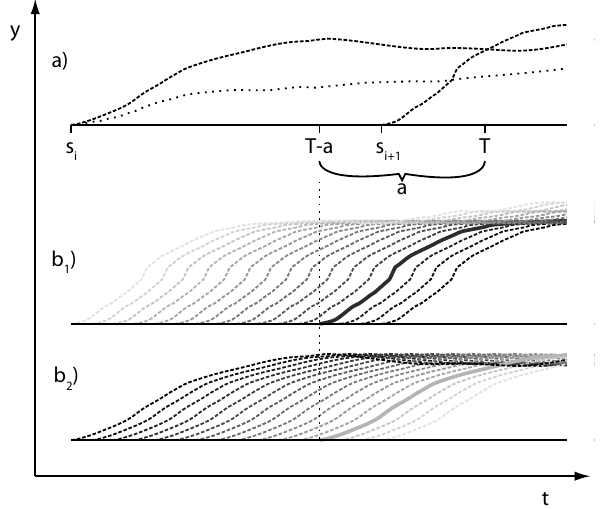
Fig. 2. Principle of GAPPARD applying changing drivers. a) dashed lines: developments of two subsequent trajectories starting from s i and s (i+1) ; dotted line: result after applying the GAPPARD method using both trajectories. b 1 ), b 2 ) weight of the trajectory on the calculation of a state variable at time point T with age a for all T − a that are between s i and s (i+1) , where T is a year after s i to which the output variable is calculated and a is the patch age (time since last disturbance). A darker trajectory stands for a bigger influence. The solid lines characterize the weight of the trajectories for T − a . Here, the trajectory starting from s (i+1) has a higher weight because T − a is closer to s (i+1) than to s i .